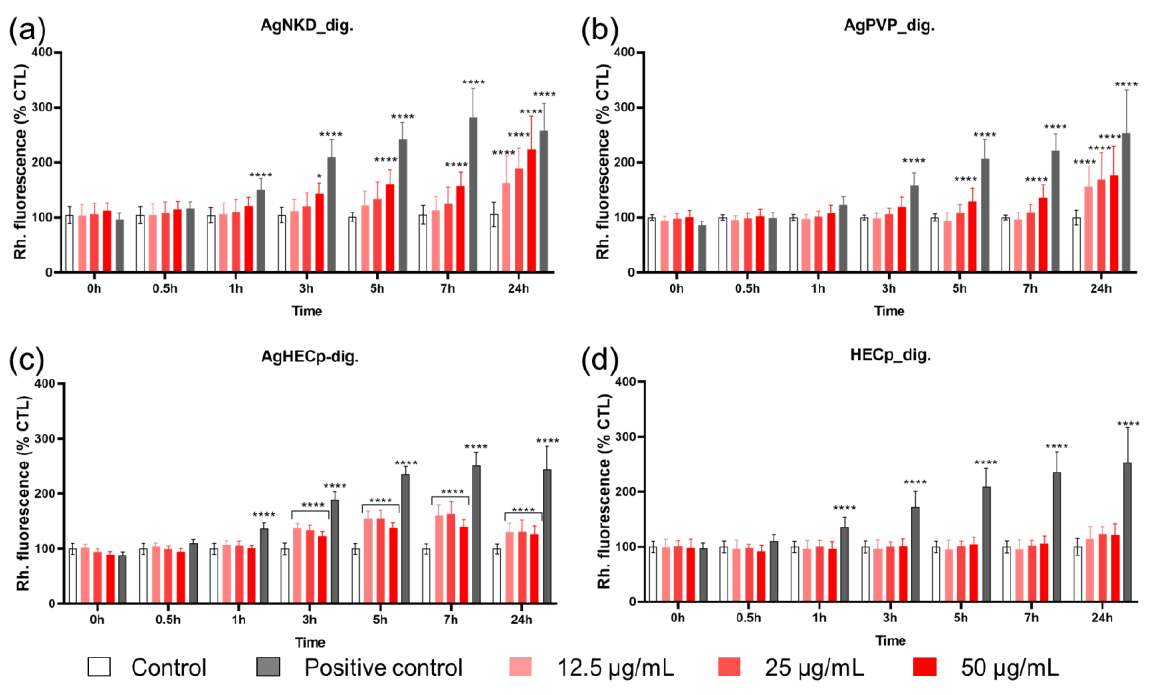
Figure 4. ROS intracellular accumulation. ROS intracellular content was assessed using DHR123 assay 24 h after HCT116 cells were exposed to digested Ag NKD ( a ), AgPVP ( b ), AgHECp ( c ) and HECp ( d ) at the indicated concentrations. Positive control (PC) refers to Luperox 250 µM. Values are the mean ± SD of three independent experiments with five replicates per experiment. Statistical significance, exposed vs. control, (*) p < 0.05, (****) p < 0.0001. Results from non-digested samples are reported in Figure S3.